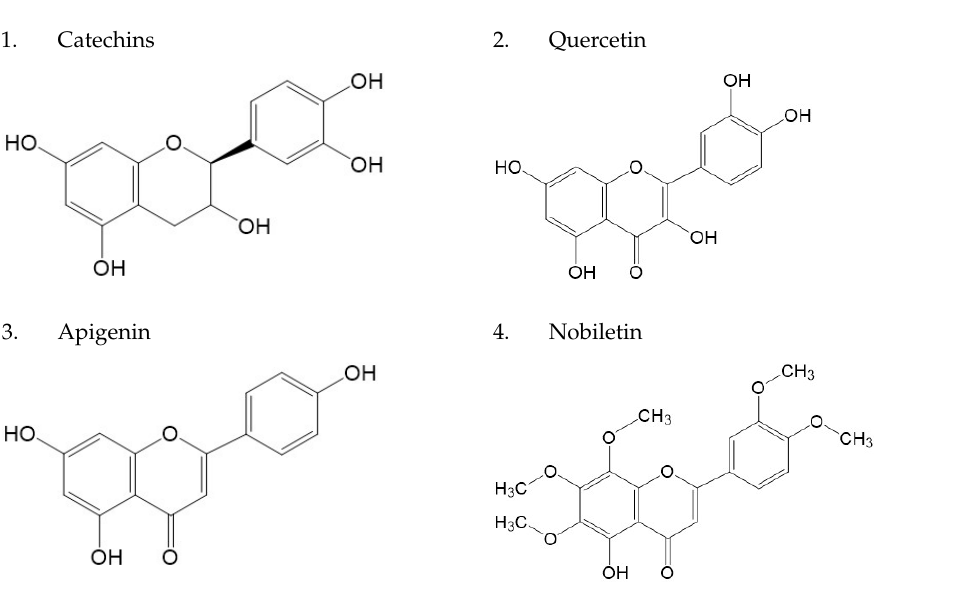
Figure 2. Chemical structures of various classes of flavonoids. Flavonoids have the basic configura- tion of C6-C3-C6. According to the structure of the C ring attached to the A and B rings and the unsaturation of the C ring, they can be divided into: flavones, flavanones, isoflavones, flavonols or flavan, and anthocyanins. Table 1. Structure of flavonoids in the text.